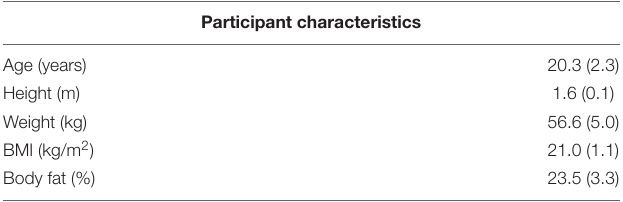
TABLE 2 | Participant characteristics measured at the start of the study ( n =